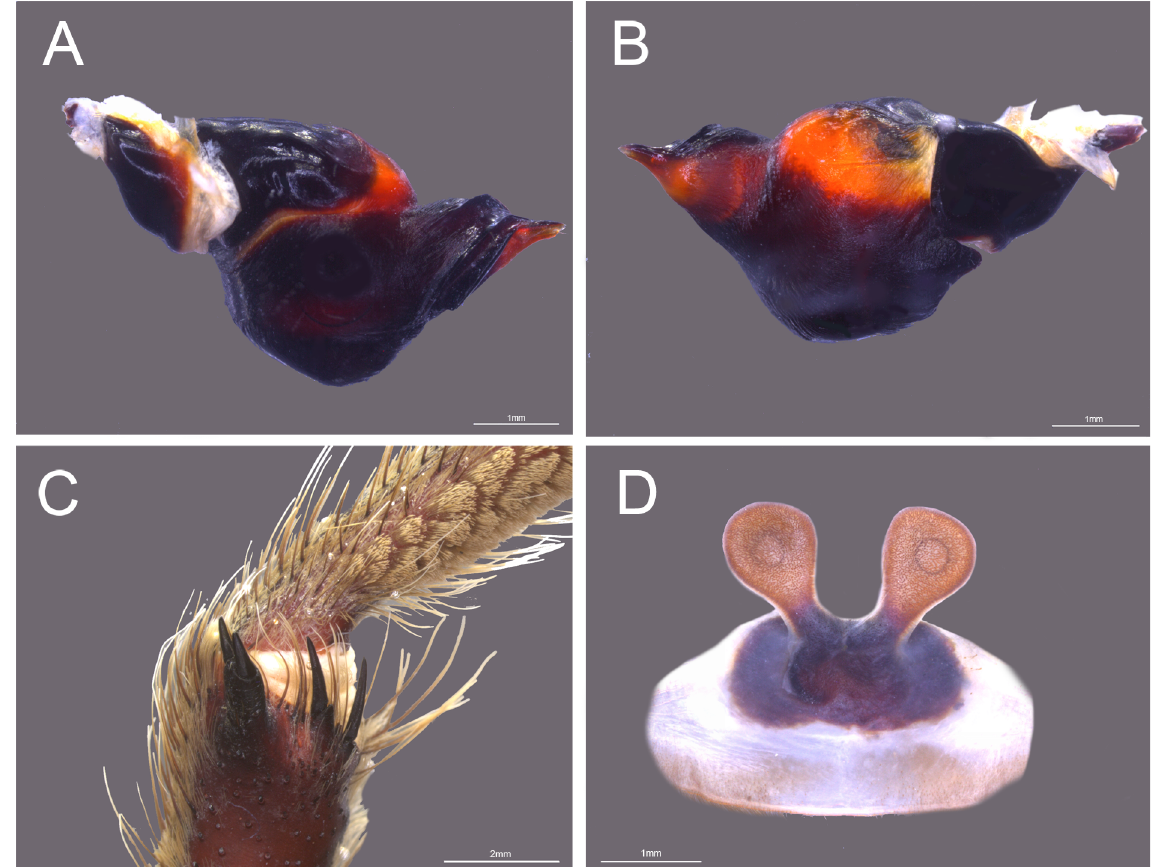
Fig. 27. Umbyquyra caxiuana gen. et sp. nov. A–C . Holotype, ♂, Floresta Nacional de Caxiuanã, Pará, Brazil (MPEG 0967). A . Palp, prolateral. B . retrolateral. C . Tibial apophysis, retrolateral. D . Paratype, ♀, same locality, spermathecae, dorsal (MPEG